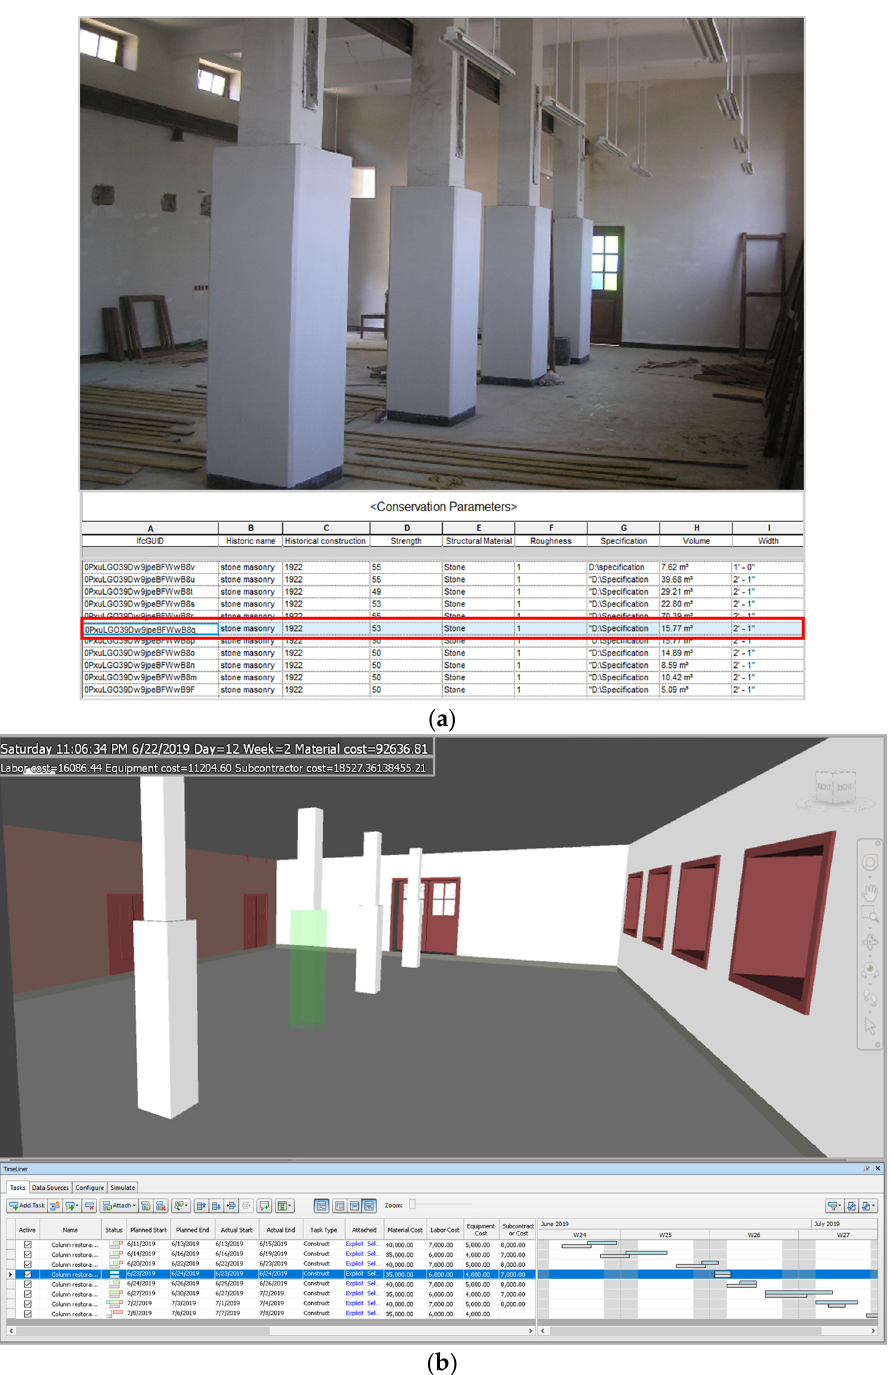
Figure 14. Visualization of the restoration planning process in BIM environment for the columns located in the heritage studio: ( a ) heritage studio columns with the as-built information (courtesy: heritage cell—DAPNED archives); and ( b ) simulation of the reconstruction process with a Gantt chart.